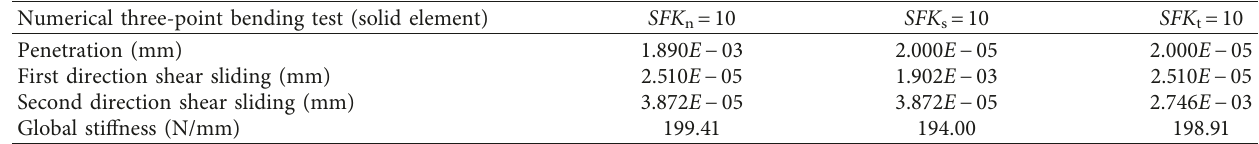
Table 4: Summary of three-point bending numerical test results (SD